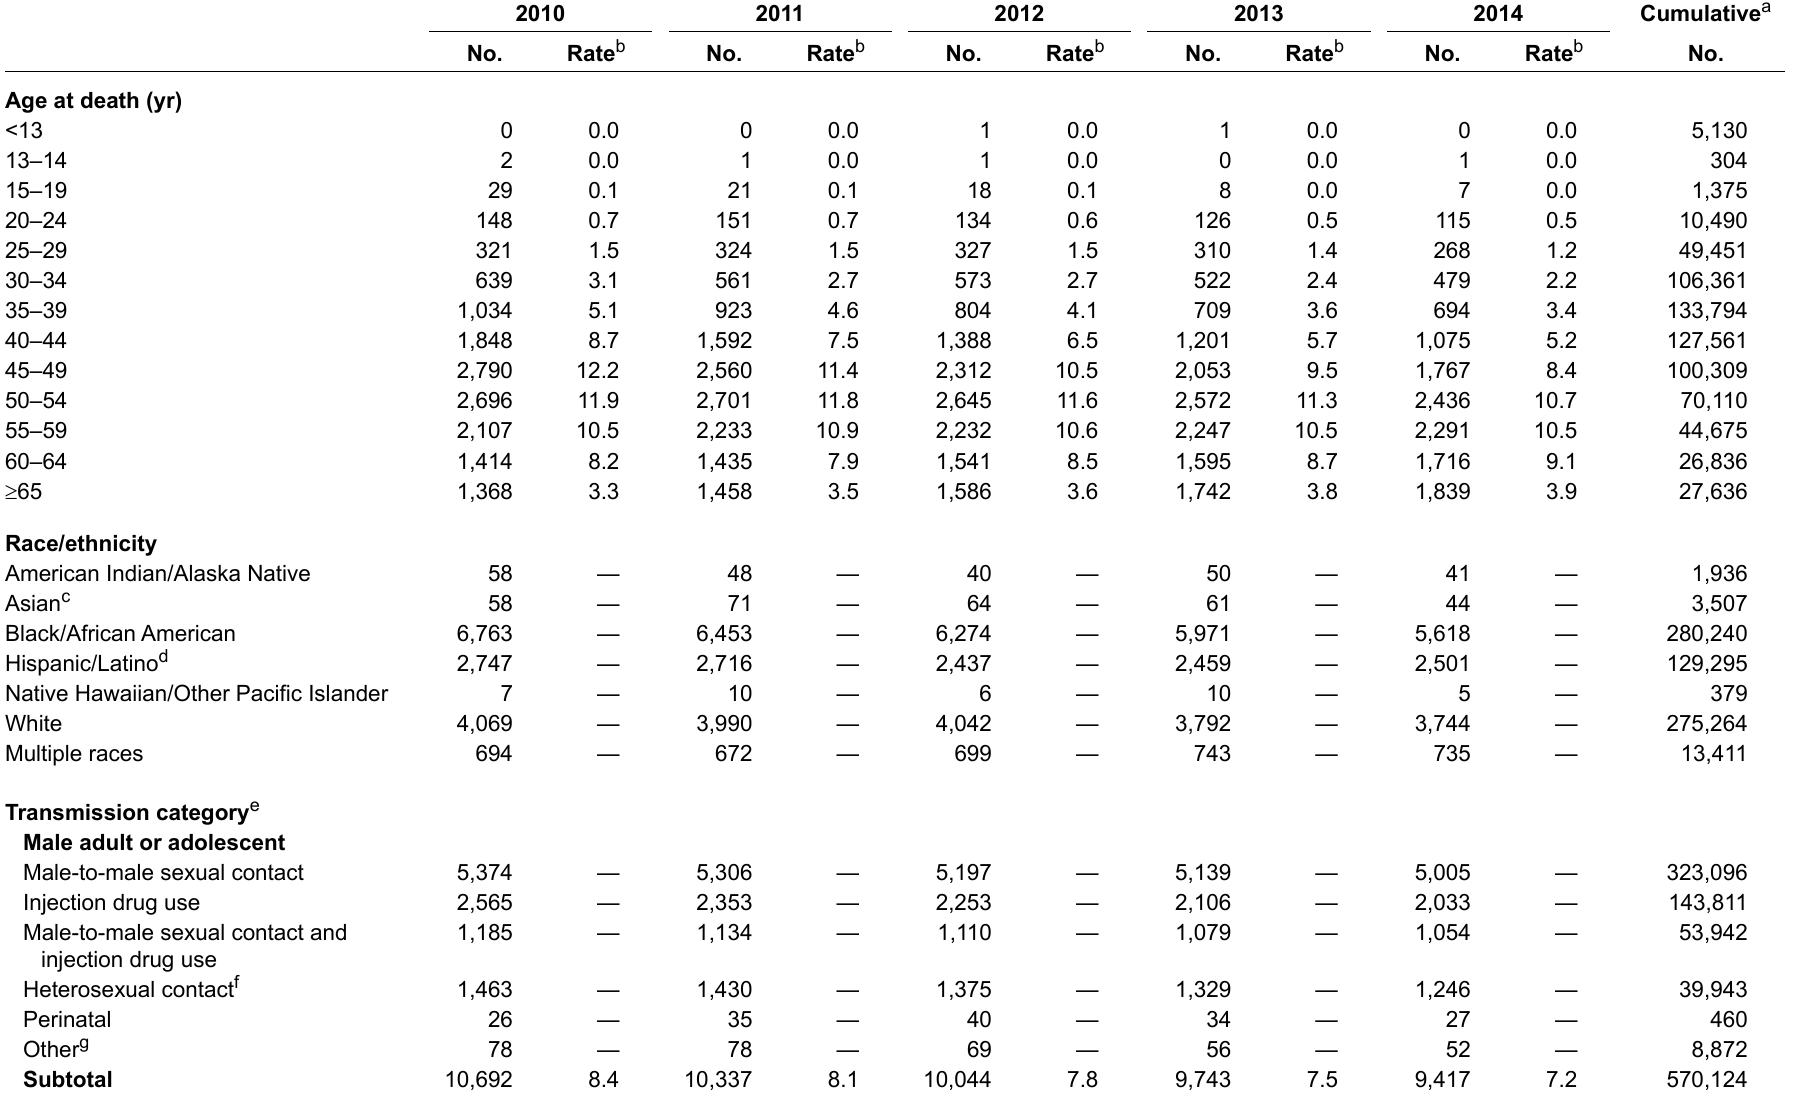
Table 13b. Deaths of persons with diagnosed HIV infection ever classified as stage 3 (AIDS), by year of death and selected characteristics, 2010–2014 and cumulative—United States and 6 dependent